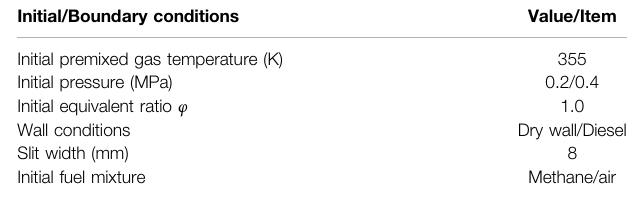
TABLE 1 | Experimental